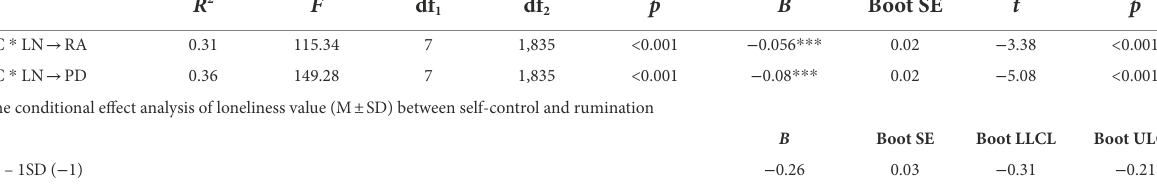
TABLE 5 Regression results of moderated mediation. R